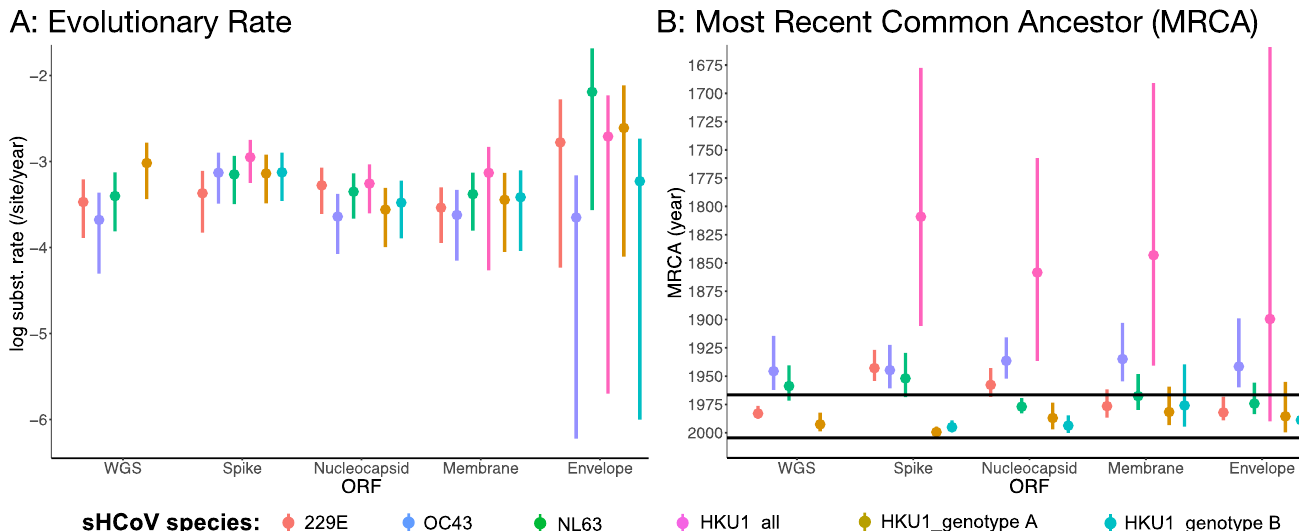
Figure 3. Estimates of the evolutionary rate ( A ) and MRCA age ( B ) for full genomes and four open reading frames (dataset D5) of the seasonal human coronavirus species. The black horizontal lines in ( B ) are the dates of first isolation for the 229E (1966), OC43 (1967), NL63 (2004), and HKU1 (2005). The WGS is missing data points for HKU1_all (collective for both genotypes) and HKU1_genotype B as sequences for HKU1_genotype B were all removed in the generation of recombination-free WGS dataset D5.